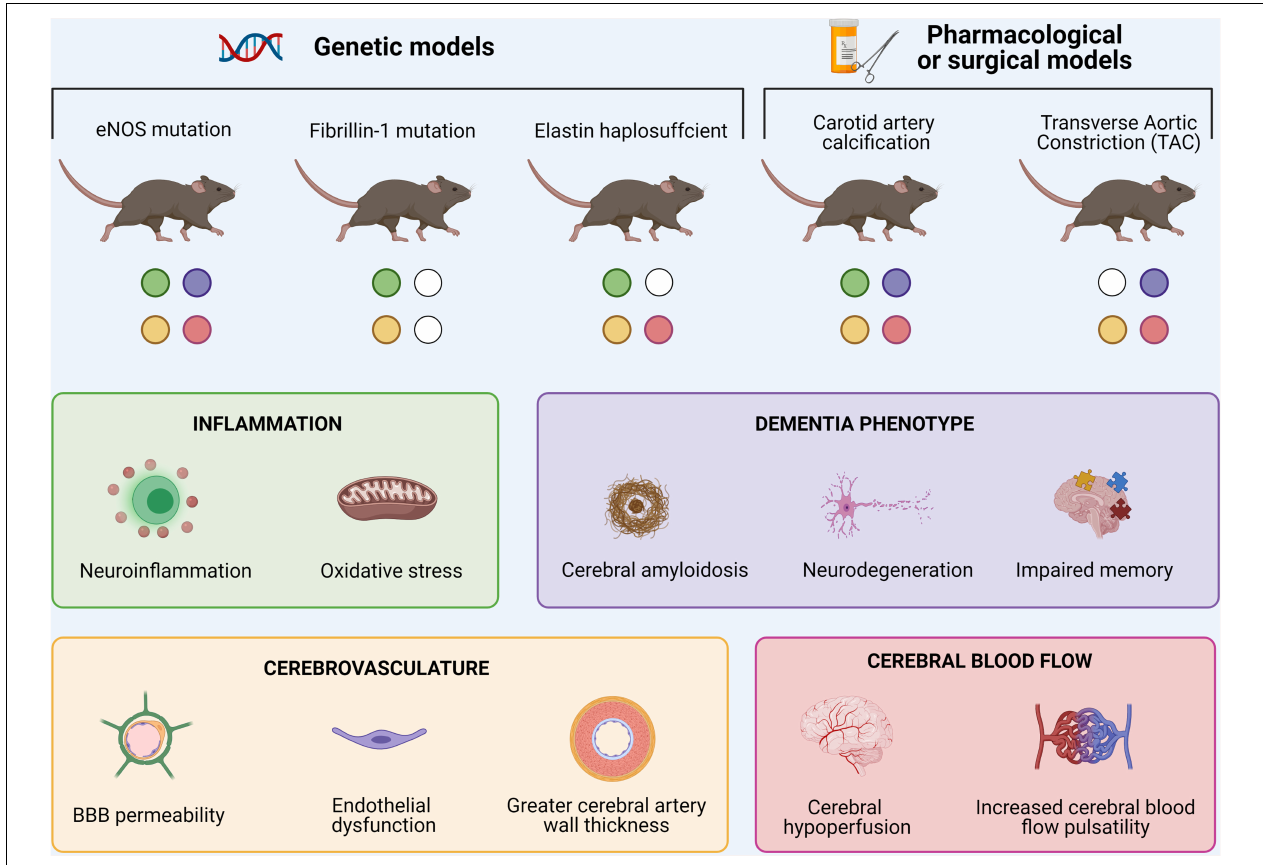
FIGURE 2 | Overview of murine models of large arterial stiffness and associated cerebral findings. Common symptoms in these rodents comprise increased cerebral neuroinflammation, changes in cerebrovascular structure and/or cerebral blood flow and typical dementia-related